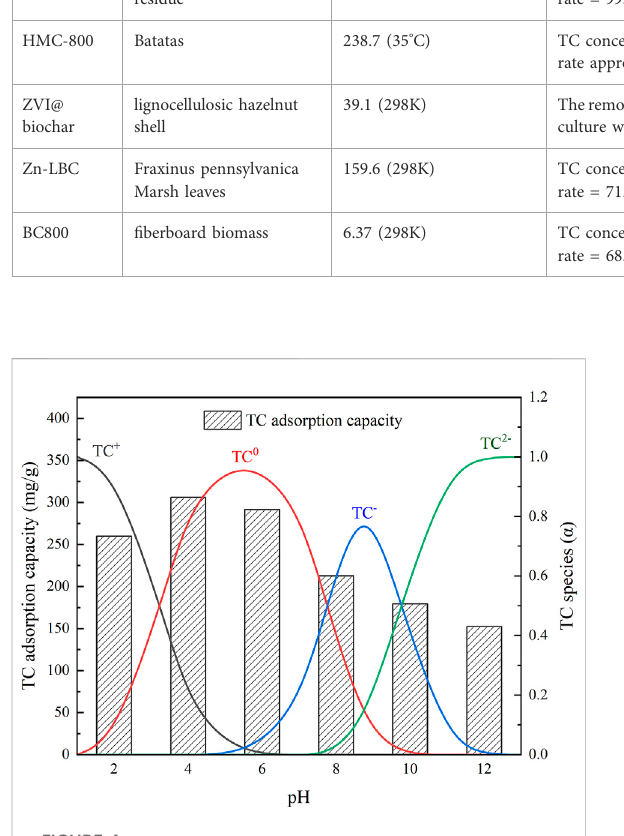
FIGURE 4 The effect of initial pH on TC adsorption capacity of IKBCH.